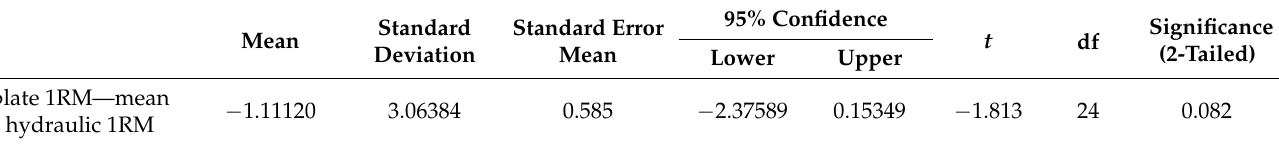
Table 3. Paired t -test of plate 1RM and mean hydraulic 1RM.